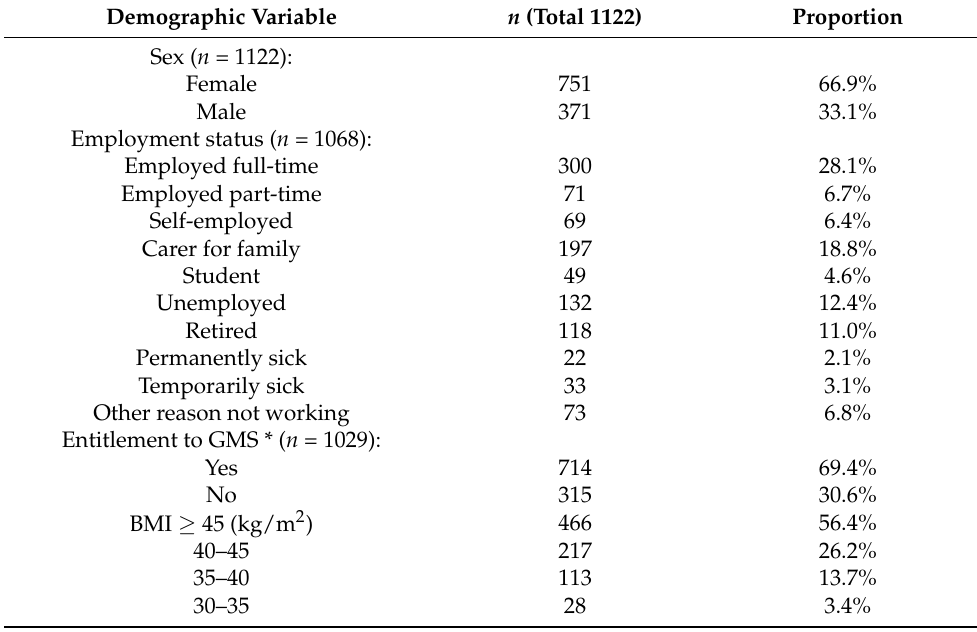
Table 1. Demographic characteristics of patients with severe obesity who started the CLANN structured lifestyle-modification